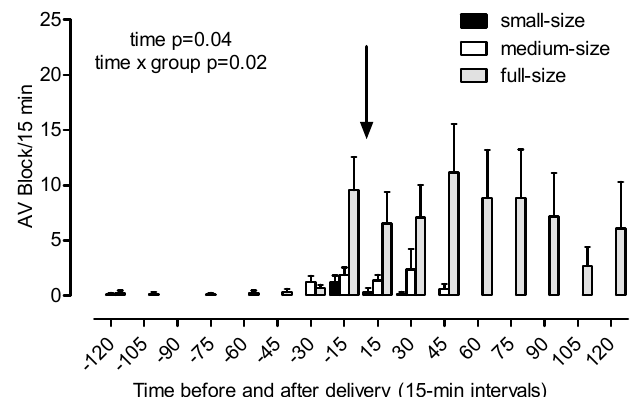
Figure 4. Second degree atrioventricular (AV) blocks (AV blocks per 15 min interval) in small (Shetland), medium-size (Haflinger), and full-size (Warmblood) mares from 120 min before to 120 min after birth of the foal (arrow). Significant differences are indicated in the figure. Fetal heart rate was close to identical in all groups on day 20 before birth. Fetal heart rate